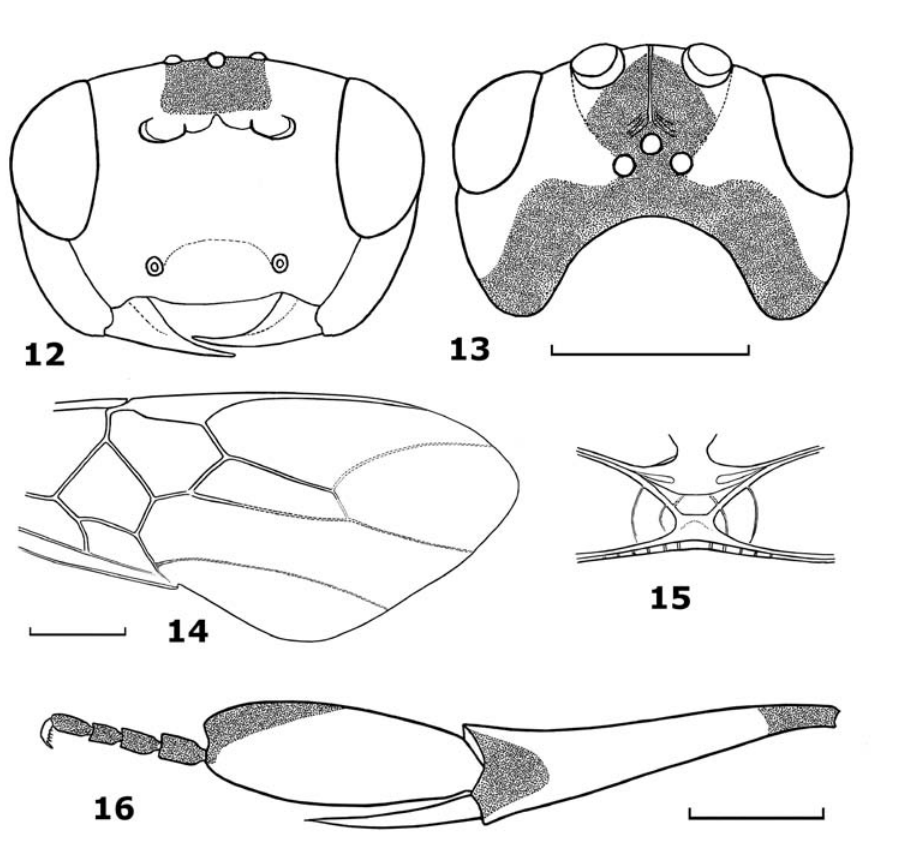
15 metanotum dorsal 16 hind tibia and